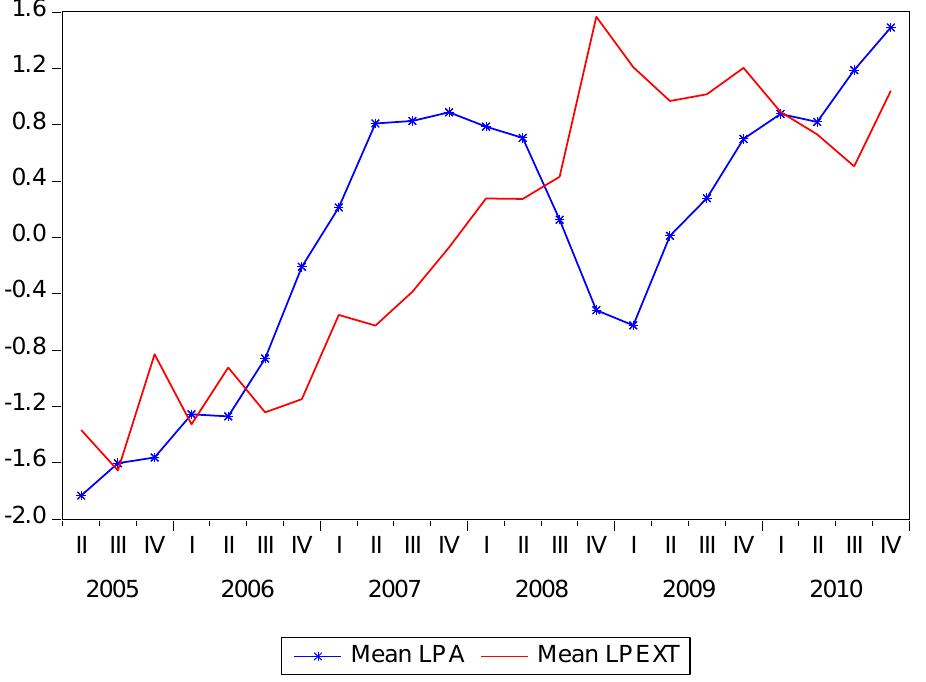
Figure 1. Average behavior of the 29 companies during the period.